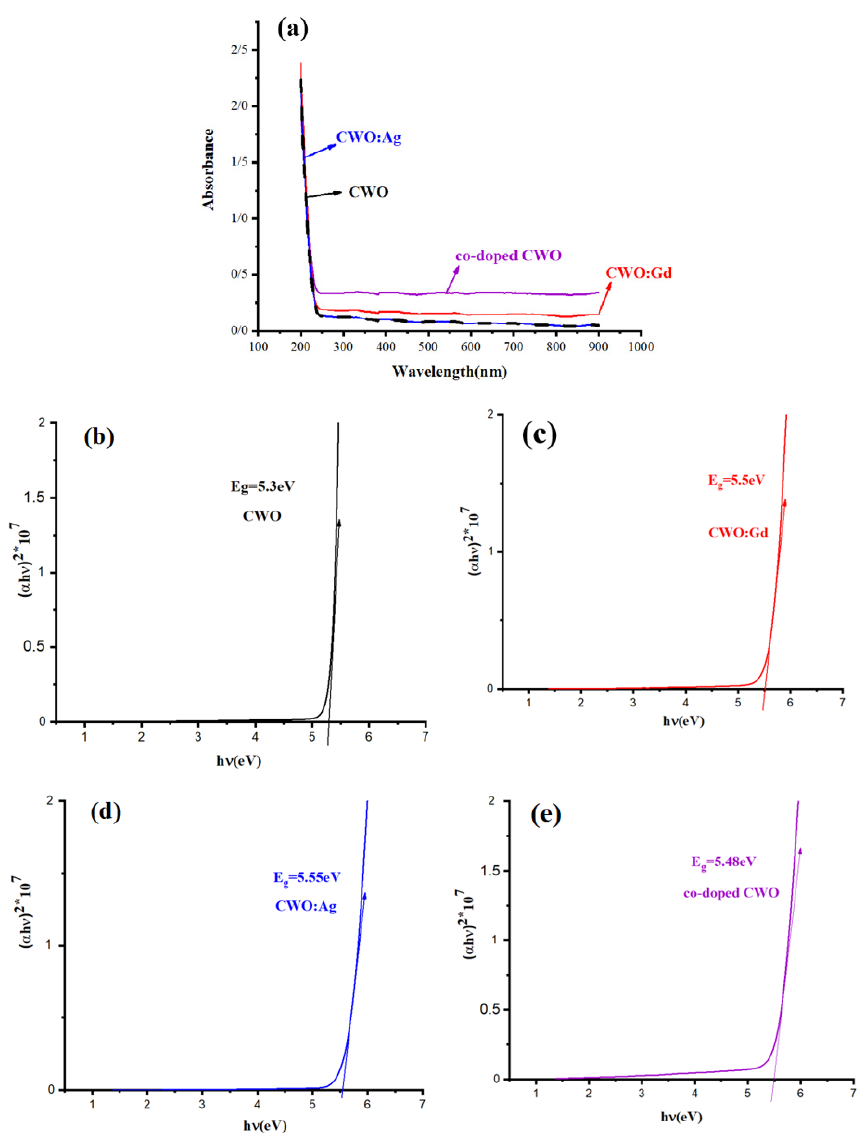
Figure 4. (a)UV-Vis absorption and (b, c, d, e)Tauc plot for CWO, CWO: Gd, CWO: Ag, and co-doped CWO nanopowders.